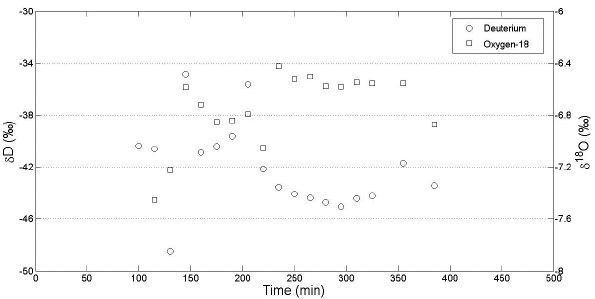
Fig. 6. The isotope values denote the calculated isotopic composi- tion of the soil water contributing to the tile-drain discharge during the hydrograph of the second